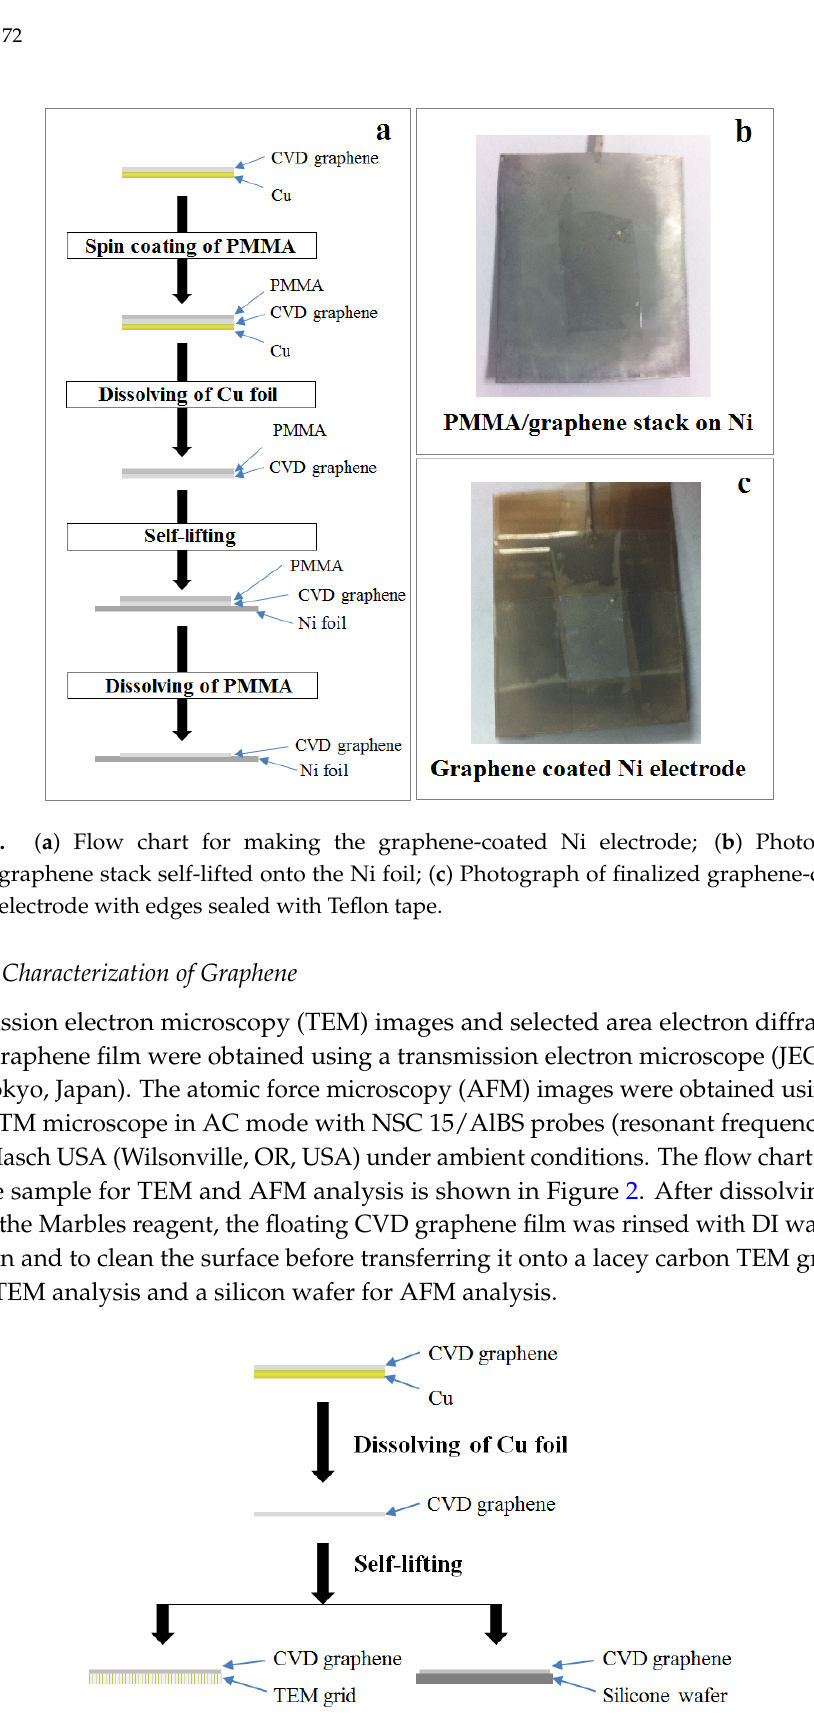
Figure 2. Flow chart for transferring graphene on the TEM grid and silicon wafer for TEM and AFM analysis.